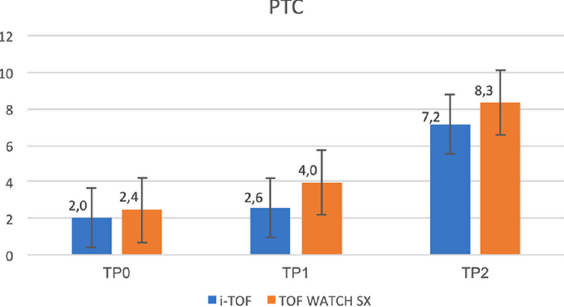
Fig. 4 Neuromuscular parameters during a deep neuromuscular blockade. Diagram showing the progressive rise of PTC, recorded during deep NMB, between i-TOF and TOF WATCH SX among the different times.